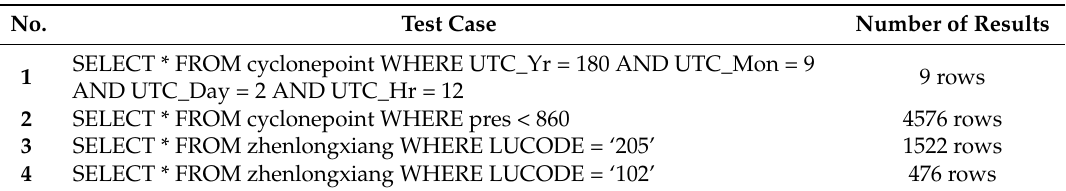
Table 4. Test cases of attribute queries.